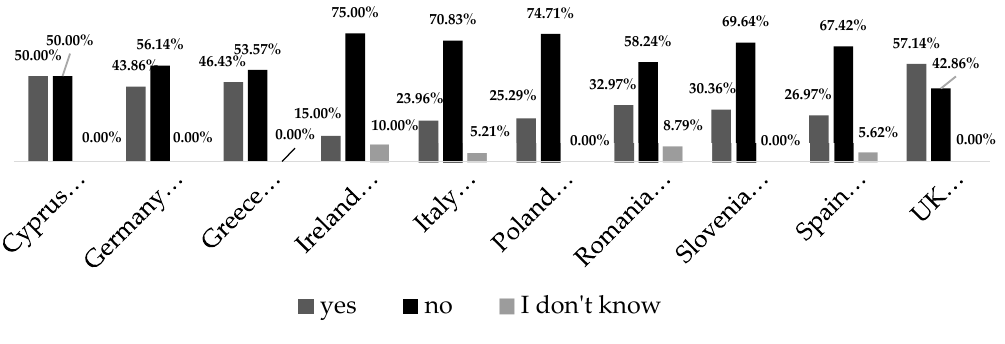
Figure 1. Implementation of an energy audit in small and medium-sized enterprises (SMEs) in the participating